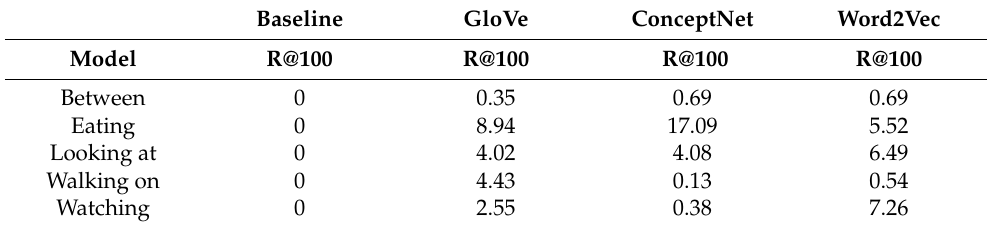
Figure 6. Comparison of the R@100 values of different models for various relationships, calculated on the test set for the SGCls task. The X -axis represents the common relationship categories in the dataset, and the Y -axis represents the R@100 values. Table 6. R@100 values of each model for selected relationship categories in the SGCls